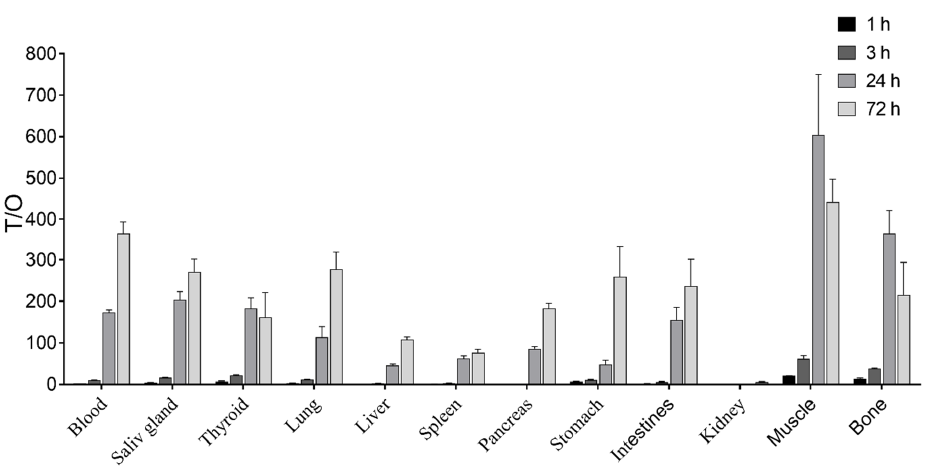
Figure 7. Tumor-to organ ratios for [ 125 I]I-BO530. Balb / c nu / nu mice with PC-3pip (GRPR and PSMA positive) xenografts were injected with 40 pmol (30 KBq) of labeled heterodimer. Data are presented as mean value ± standard